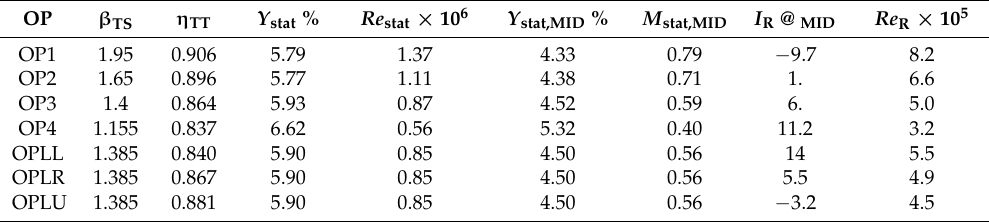
Table 5. Stage efficiency and stator total pressure loss for all the tested operating conditions.